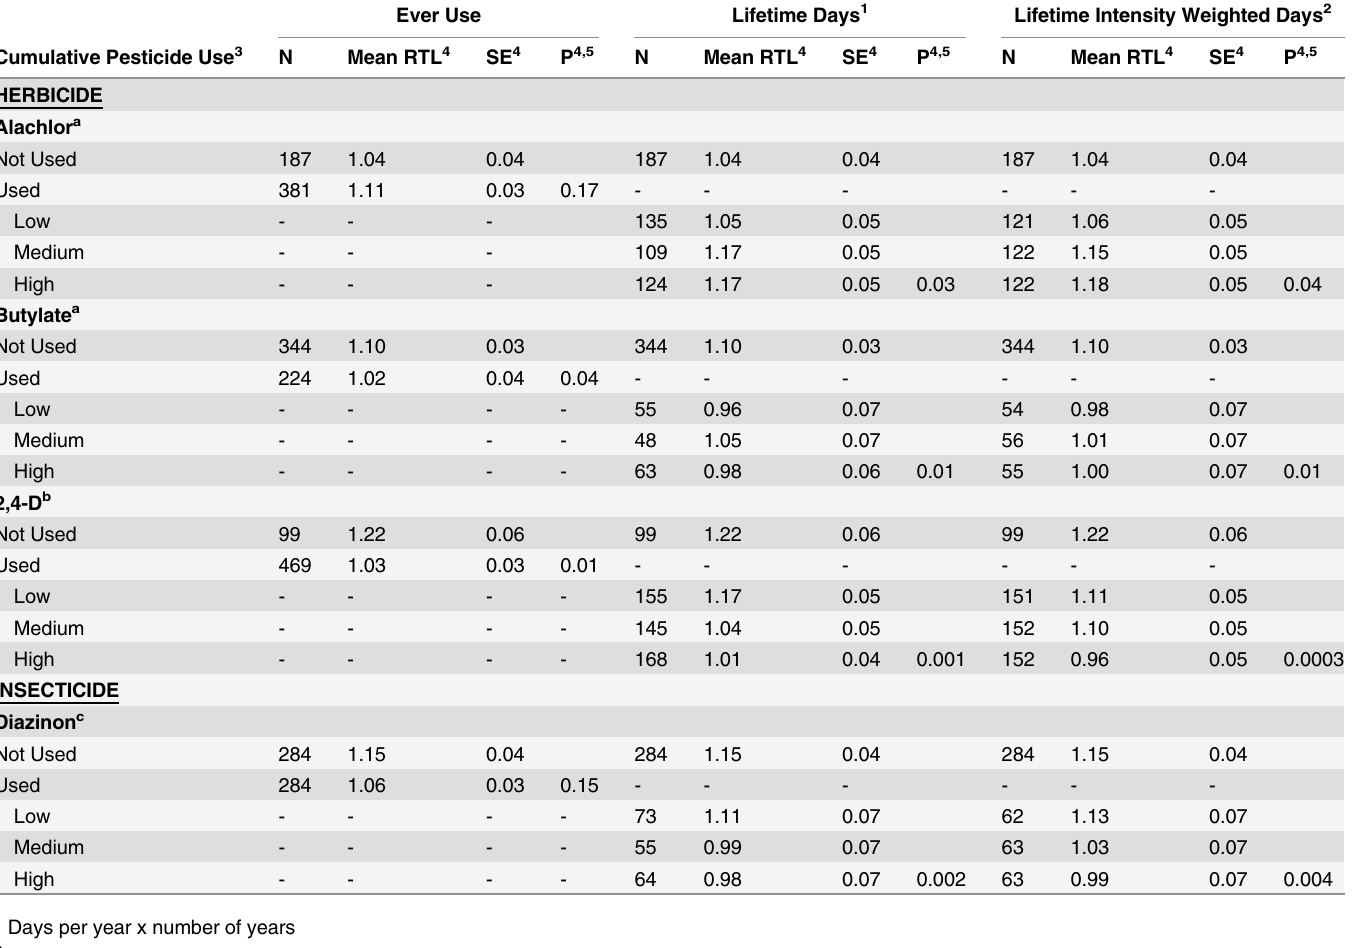
Table 2. Cumulative lifetime pesticide use and mean relative telomere